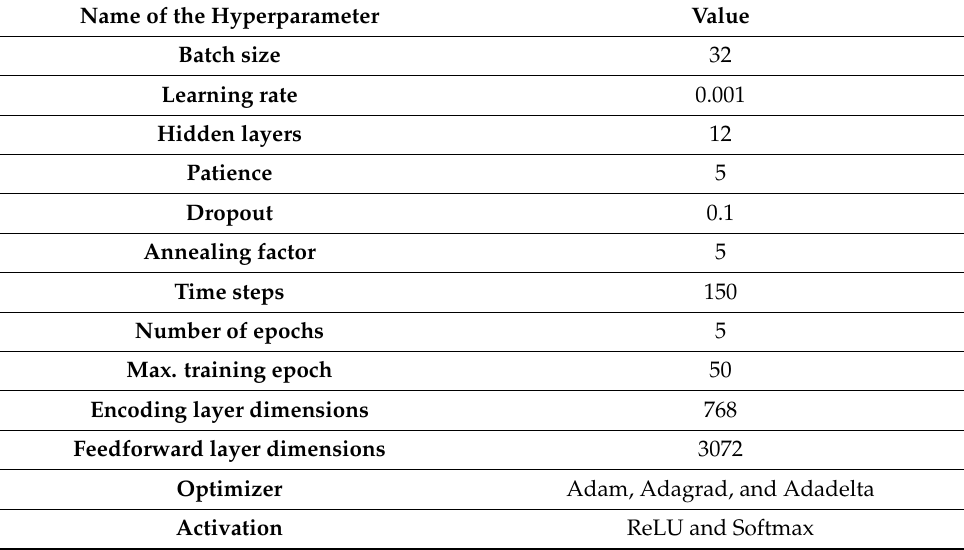
Table 5. Hyperparameter values used under the RoBERTa model with MVF